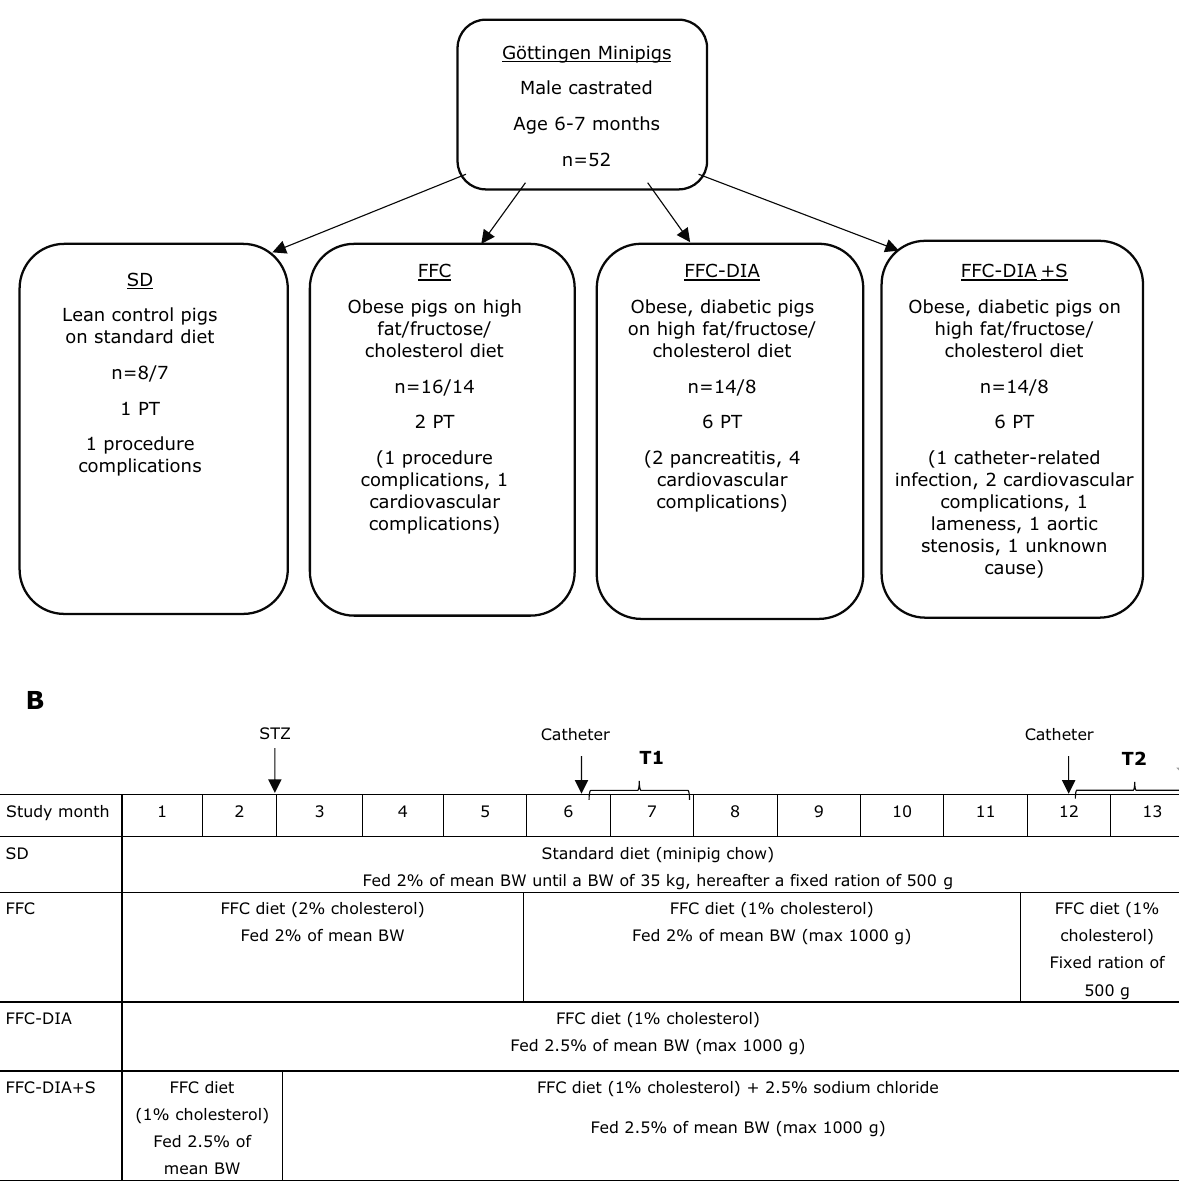
Figure 1. Study overview. ( A ) Fifty-two male castrated Göttingen Minipigs were included in the study and 15 were terminated prematurely. The numbers and reasons for premature termination (PT) are described under each group. The procedure-related complications occurred during investigations of other end points in the same animals (unrelated to the present study). ( B ) Timeline and details of feeding and tests in each of the four groups over the study period. FFC: high fat/fructose/cholesterol diet, STZ: induction of diabetes with streptozotocin, T1: mid-study in vivo evaluations, T2: end-study in vivo evaluations. Grey arrow indicates termination and tissue sampling. Modified from Schumacher et al. with permission 50